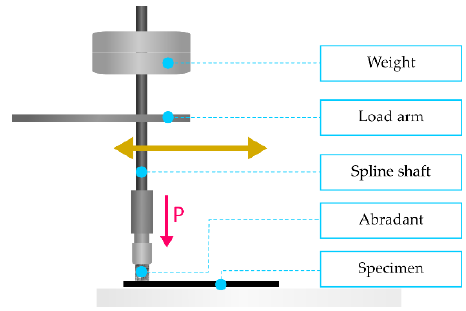
Figure 1. Scheme of the action of force during the friction process.